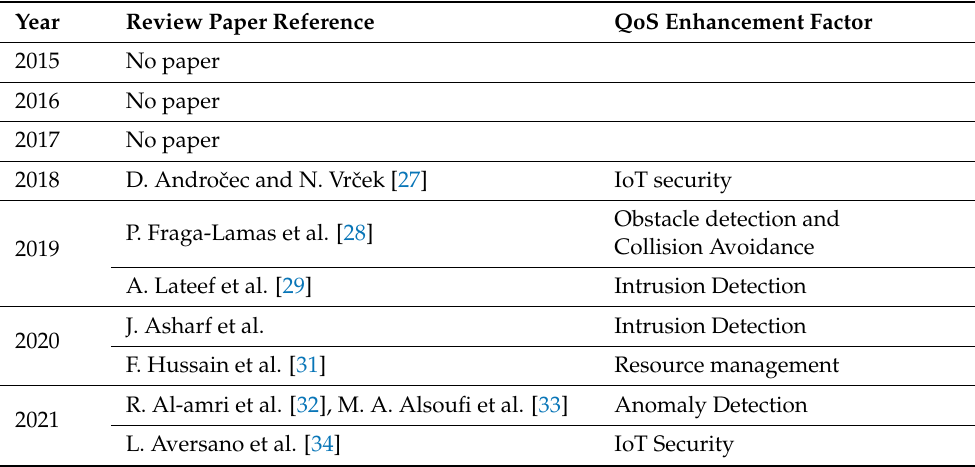
Table 1. Previous review papers about the use of DL-based models for QoS enhancement in